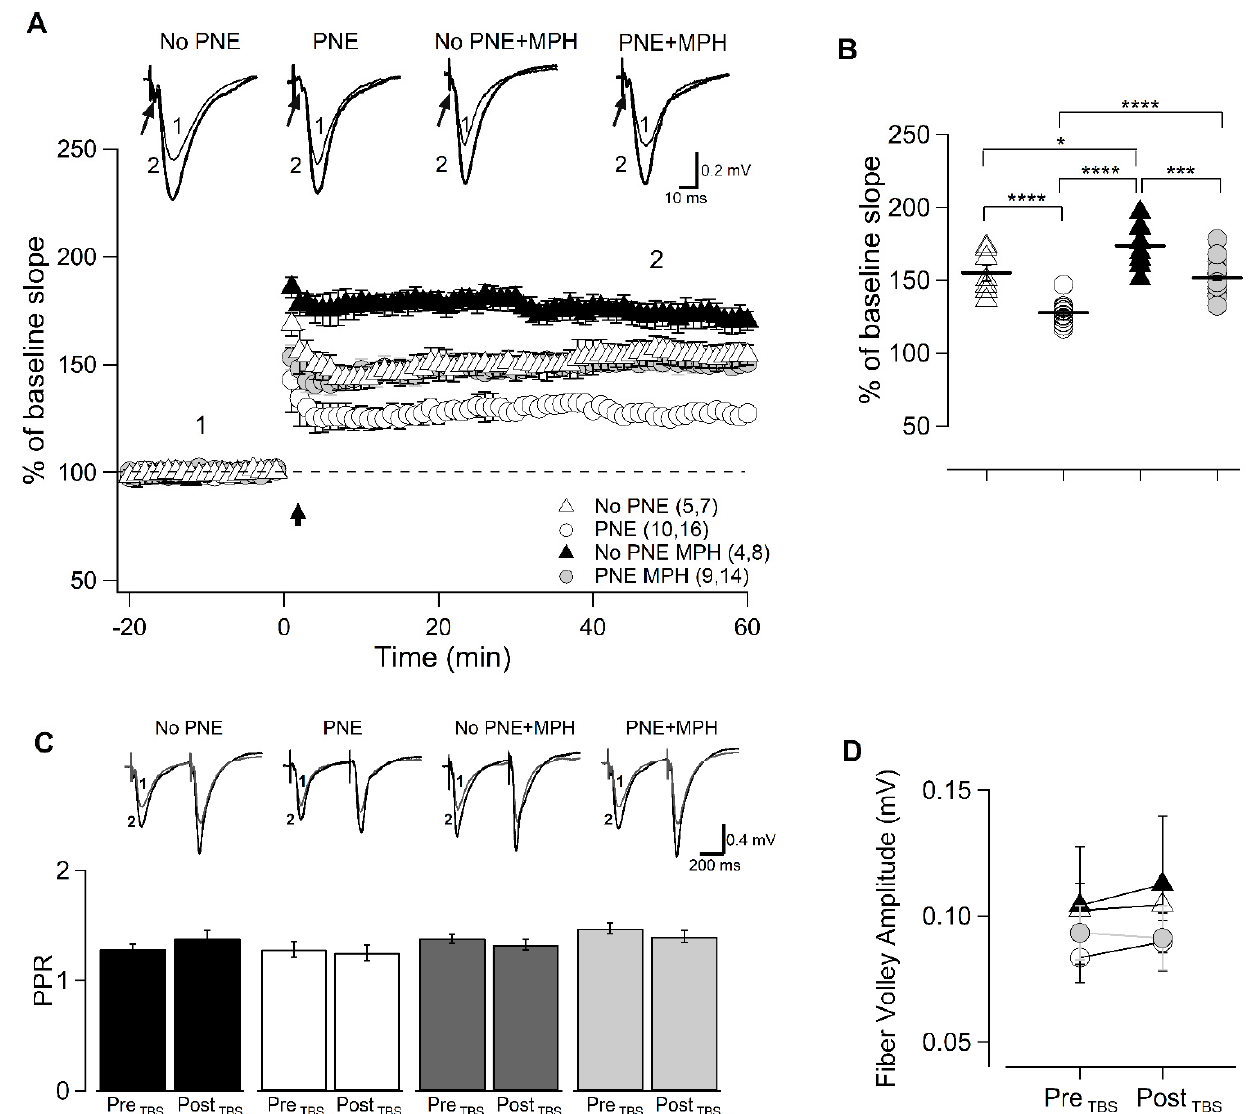
Figure 2. Hippocampal LTP is reduced in PNE animals and restored after single MPH administration. ( A ) Normalized fEPSP slope measurements before and after LTP induction (arrow) in hippocampal slices from no − PNE, MPH-treated no − PNE, PNE, and MPH − treated PNE mice. Inset: Superimposed traces of fEPSP recorded 10 min before (1) and 50 min after (2) TBS for the corresponding experimental groups. Arrows indicate fiber volley preceding postsynaptic signals. ( B ) Scatter plot of normalized fEPSP slope measurement evaluated 50 min after application of TBS (marked 2) during LTP protocol. Hippocampal LTP is significantly lower in PNE mice compared to control no − PNE mice (PNE: 127.8 ± 1.75, n = 10,15; no − PNE: 155.1 ± 5.58, n = 10,12, one − way ANOVA followed by Tukey post hoc test, F (3,41) = 30,06; p **** < 0.0001). However, LTP in MPH − treated PNE animals is significantly higher than in untreated PNE mice (PNE: 127.8 ± 1.75, n = 10,15; PNE + MPH: 151.6 ± 3.246, n = 9,14, p * < 0.05; p ***< 0.01; p **** < 0.001) ( C ). P2/P1 ratio (PPR) measurements obtained by paired pulse protocol before and after induction of LTP by TBS in brain slices taken from the four experimental groups. There are no significant differences in the ratio before and after LTP induction from no − PNE, MPH − treated no − PNE, PNE, and MPH − treated PNE mice, nor are there significant differences amongst the groups (PNE (preTBS) :1.29 ± 0.069, PNE (post TBS) : 1.26 ± 0.073; no − PNE: (preTBS) : 1.287 ± 0.04; no − PNE (postTBS) :1.381 ± 0.075; no − PNE + MPH (preTBS) : 1.394 ± 0.04; no − PNE + MPH (postTBS) : 1.338 ± 0.05; PNE + MPH (preTBS) : 1.486 ± 0.05; PNE + MPH (postTBS) : 1.413 ± 0.06; p > 0.05). Inset: Superimposed traces of fEPSPs recorded during the paired-pulse protocol before (1) and after TBS (2) in brain slices from the four experimental groups. ( D ) Presynaptic fiber volley amplitude before and after induction of LTP by TBS in slices